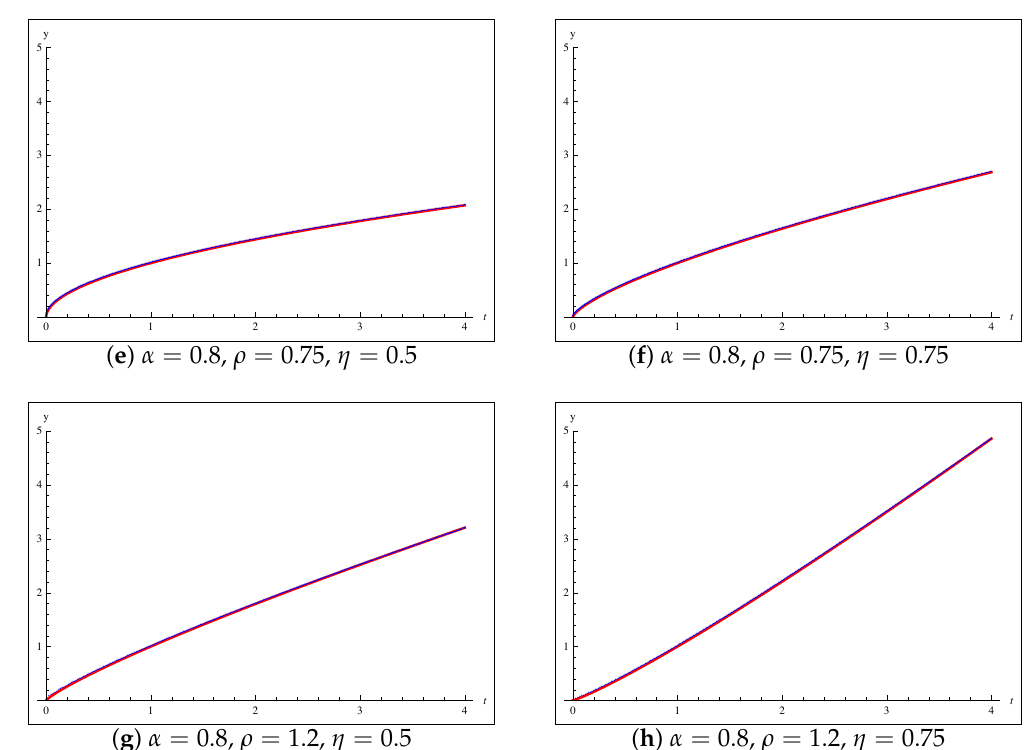
Figure 2. Plots of numerical solutions to the IVP (55), when N = 400: ( Red ) Exact solution; ( Blue ) Predictor-corrector algorithm numerical